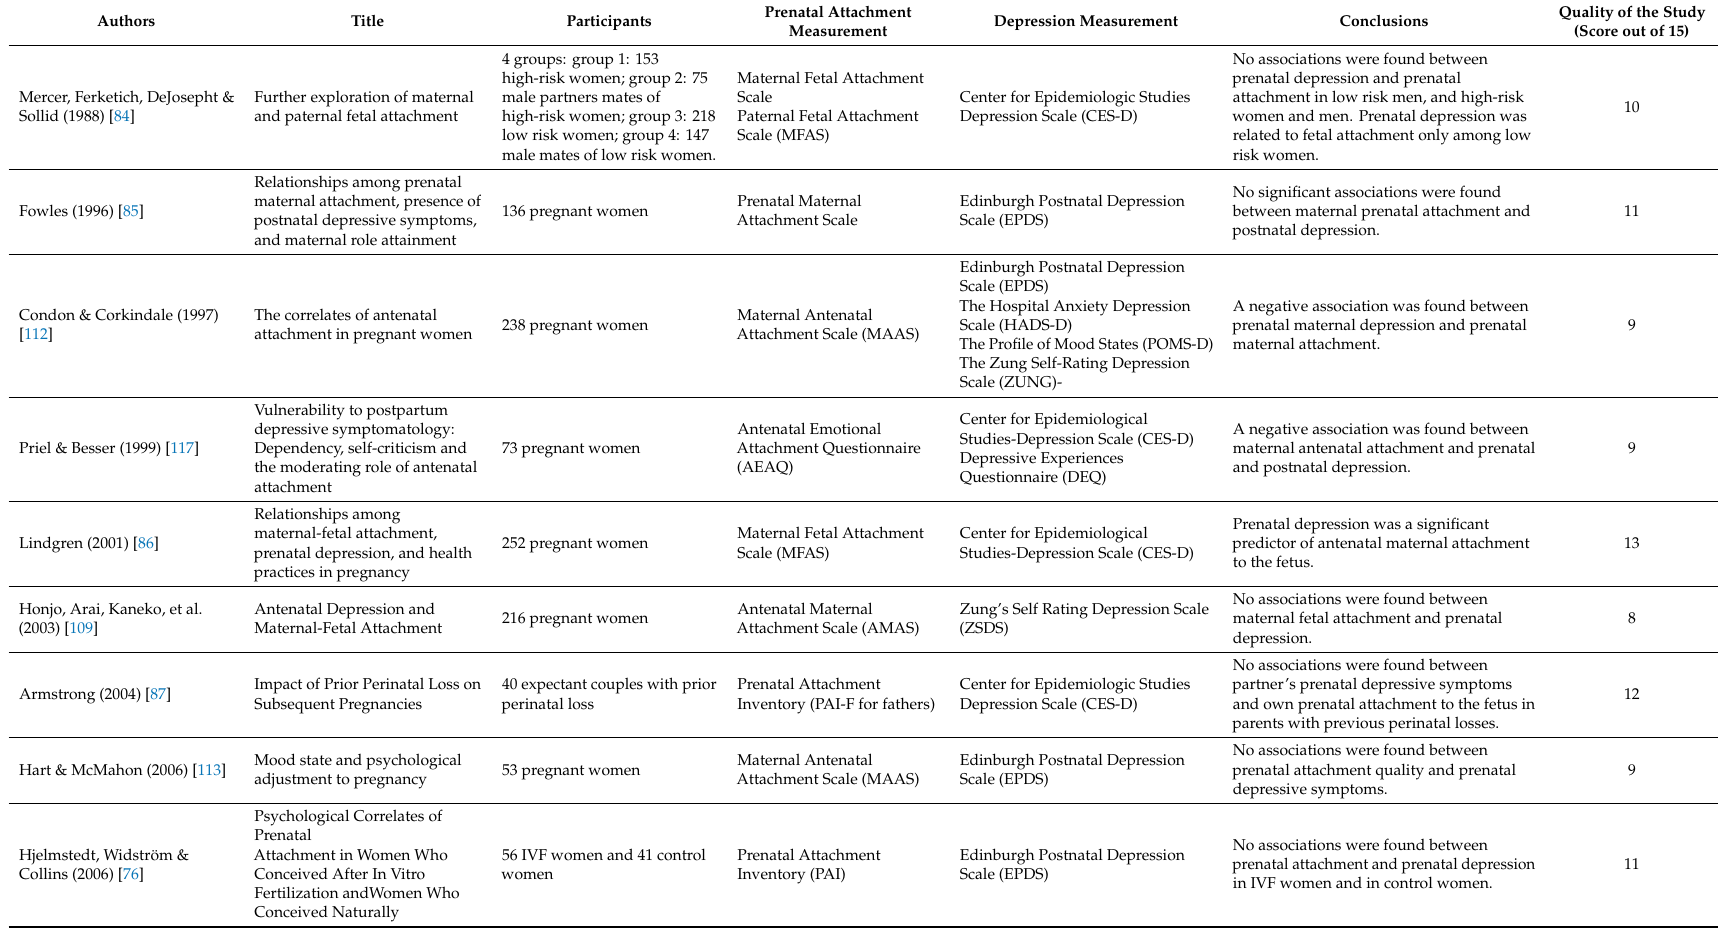
Table 1. Studies included in the systematic